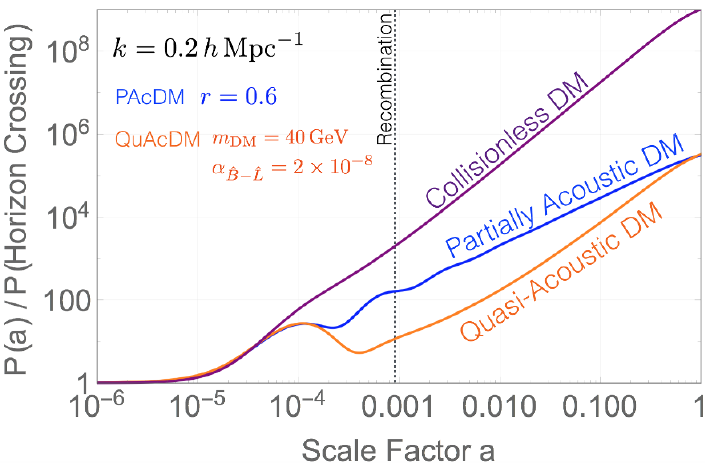
Figure 2 . An example of the evolution of dark matter power spectrum in the Cold dark matter (pur- ple), Partially Acoustic dark matter (PAcDM, blue), and Fully Acoustic dark matter (QuAcDM, orange) cases. In the QuAcDM scenario, which corresponds to the case when both ^(cid:10) and ^ (cid:28) interact with the dark radiation, the oscillation delays the linear growth of the density contrast during the matter domination phase. This feature results in a suppression of the matter power spectrum. In the PAcDM scenario, which corresponds to the case when only ^ (cid:28) scatters with the dark radiation, the slower growth of the power spectrum allows a smaller deviation from the CDM case during the CMB time ( a (cid:24) 10 (cid:0) 3 ) and the same suppression of power spectrum today ( a ’ 1) as in